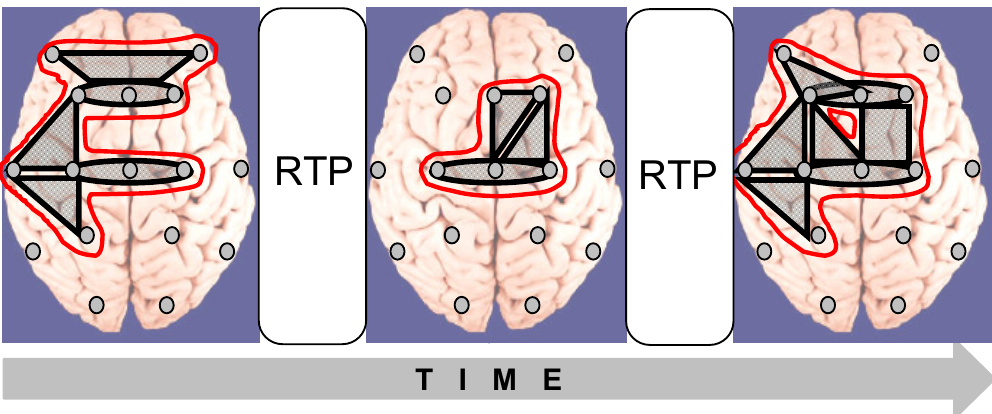
Figure 6. Brain activity dynamics. It is presented as a chain of periods of short-term metastable states (operational modules, OM) of the individual brain subsystems (grey shapes), when the numbers of degrees of freedom of the neuronal assemblies are maximally decreased. Larger shapes outlined in red illustrate complex OMs which are separated from each other by rapid transitional periods (RTPs). During such RTPs, the evaluation about the achieved (previous) state is done and the decision of what should be done and how to achieve the new adaptive state is made [5, 9]. Note, that in the transition period, cortical system (complex and simple OMs) rapidly breaks functional